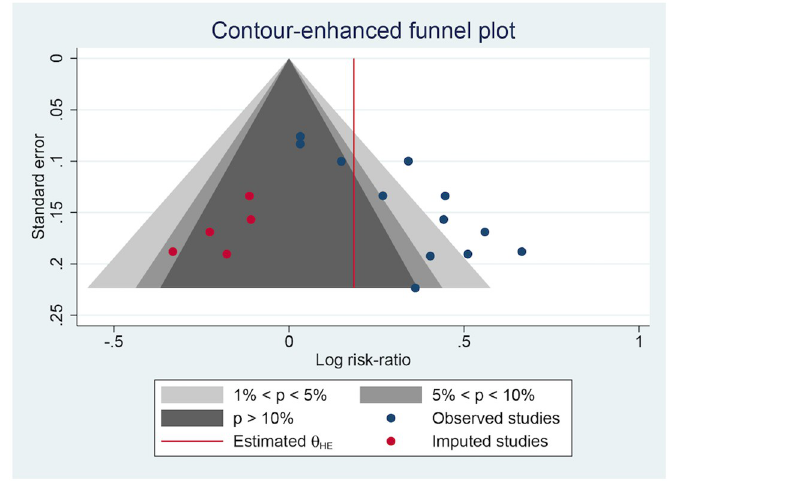
Fig 12. The contour-enhanced plot of the QoL.